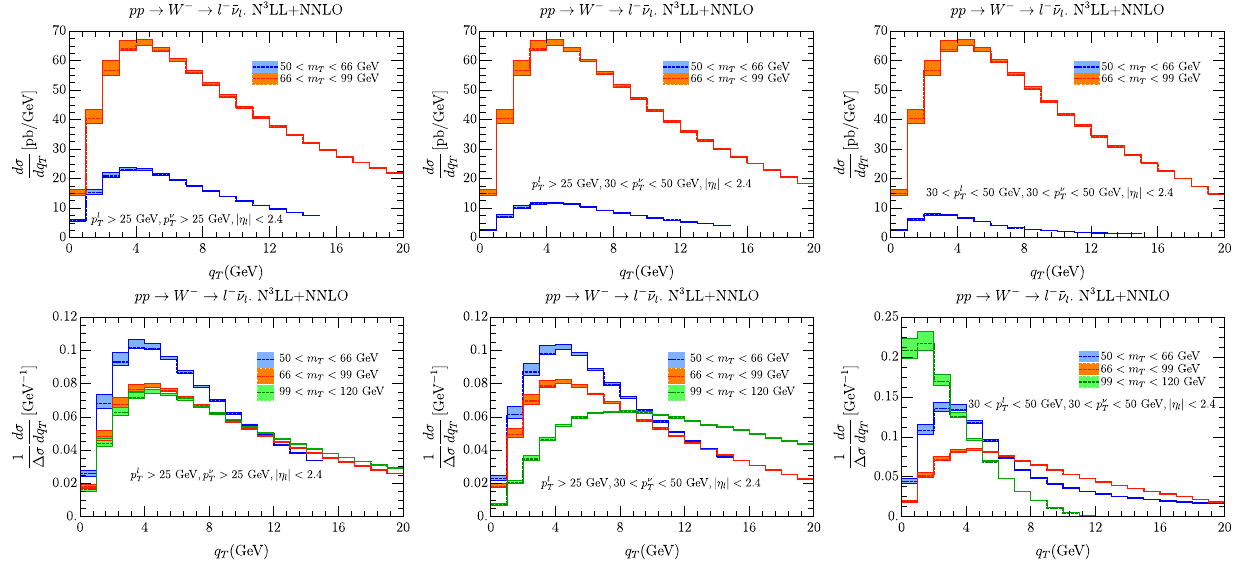
Fig. 1 (top) Unnormalized cross sections for W − production with different intervals of lepton cuts. (bottom) Normalized cross sections for W − production with different intervals of lepton cuts